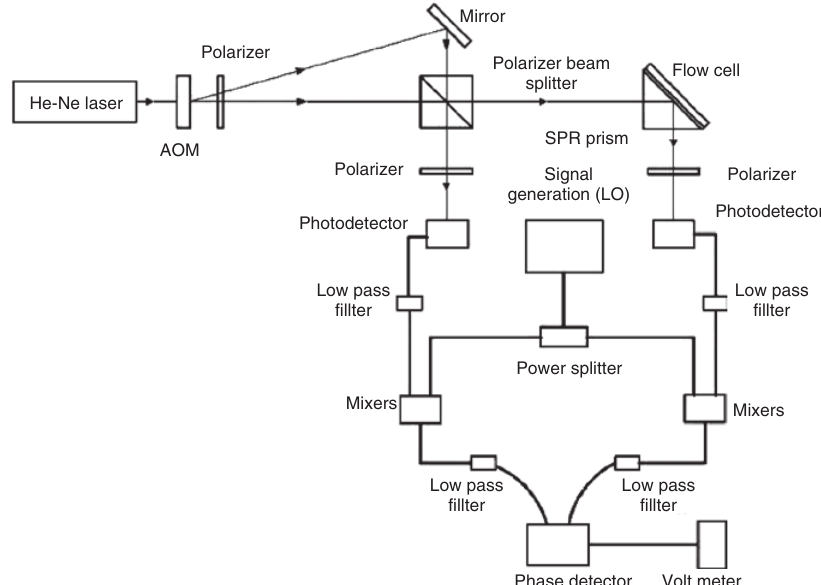
Figure 4: Schematic of phase detection sensing configuration with AOM. Reprinted with permission from Ref. [33].